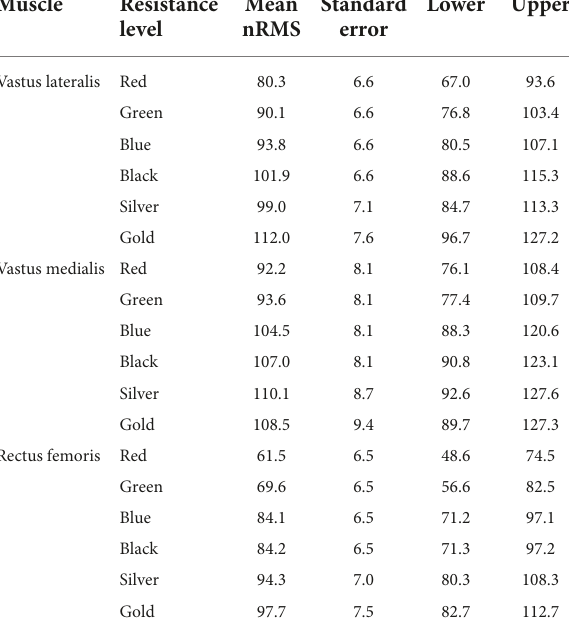
FEV 1 of 47.3 ± 19.3% of predicted value. Table 1 shows the demographic and clinical data of the participants. Table 2 and